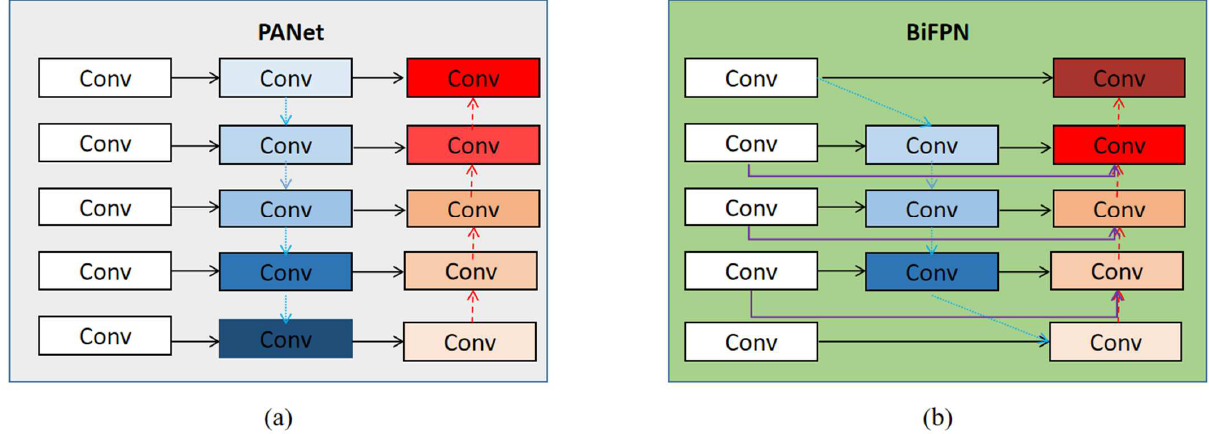
Figure 3. PANet and BiFPN network structure. ( a ) is the PANet network structure, and ( b ) is the BiFPN network structure. In this figure, the blue arrows are top-down paths, which convey the semantic information of high-level features, and the red arrows are bottom-up paths, which convey the location information of low-level features. The purple part is an extra path added when the input point and output point are located in the same layer, which is used to fuse more feature information [55].